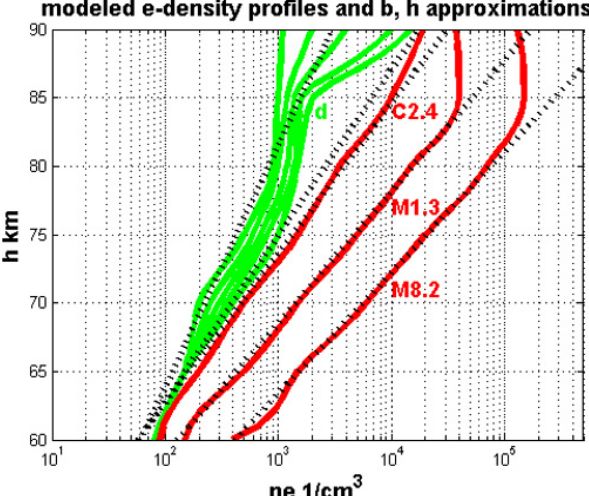
band center photon energies E sh and E lo for the photon flux ratio: